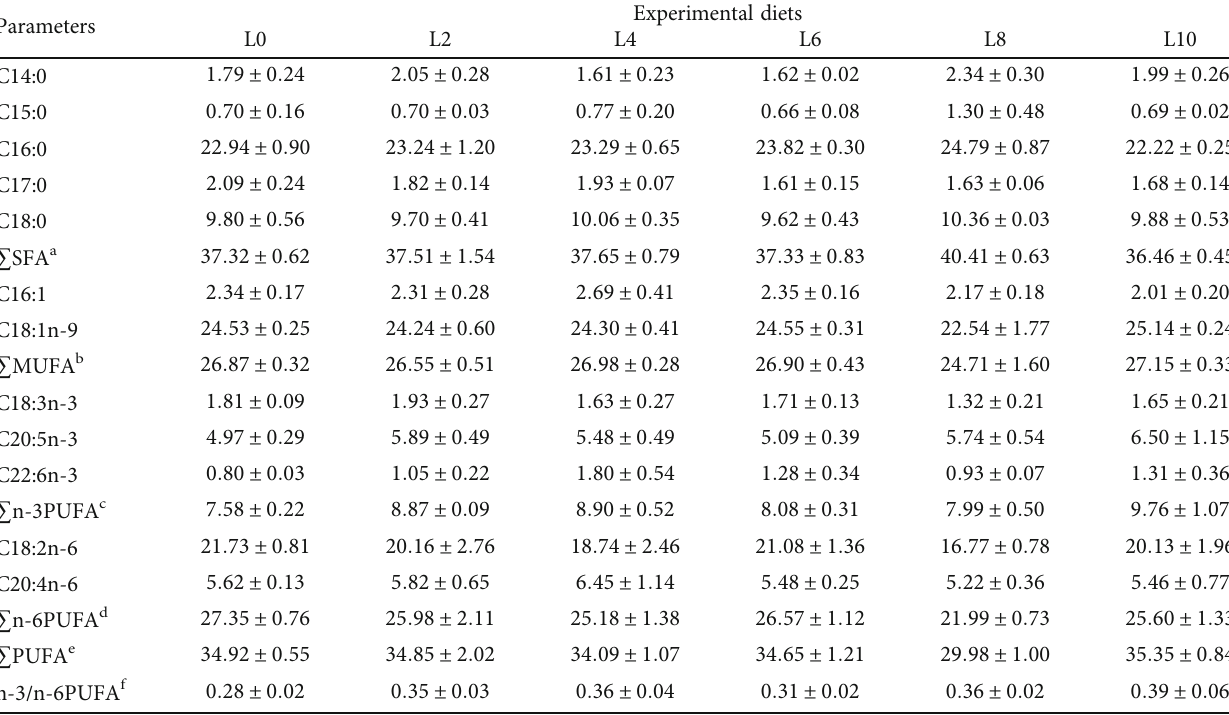
Experimental diets